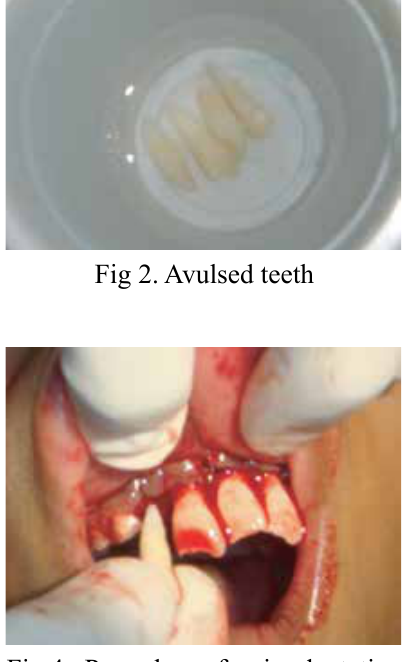
Fig 3. Empty bony sockets